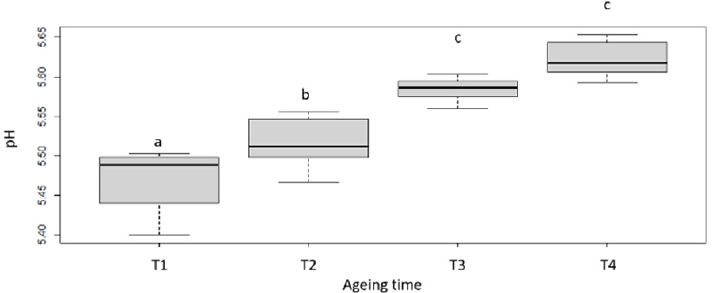
Figure 2. pH evolution with ageing time. T1, T2, T3 and T4 correspond with the different ageing length (respectively 7, 16, 35 and 60 days). Box-plot explanation: the central value represents